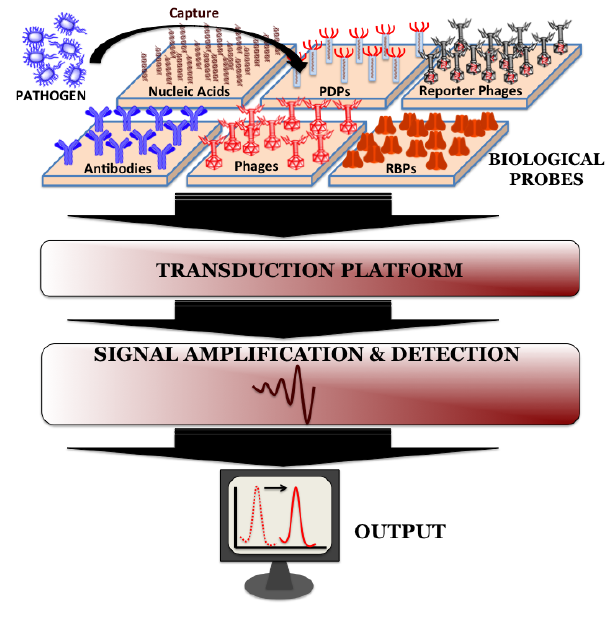
Figure 2. A schematic of various components of a typical biosensor highlighting the available phage-based molecular probes for pathogen